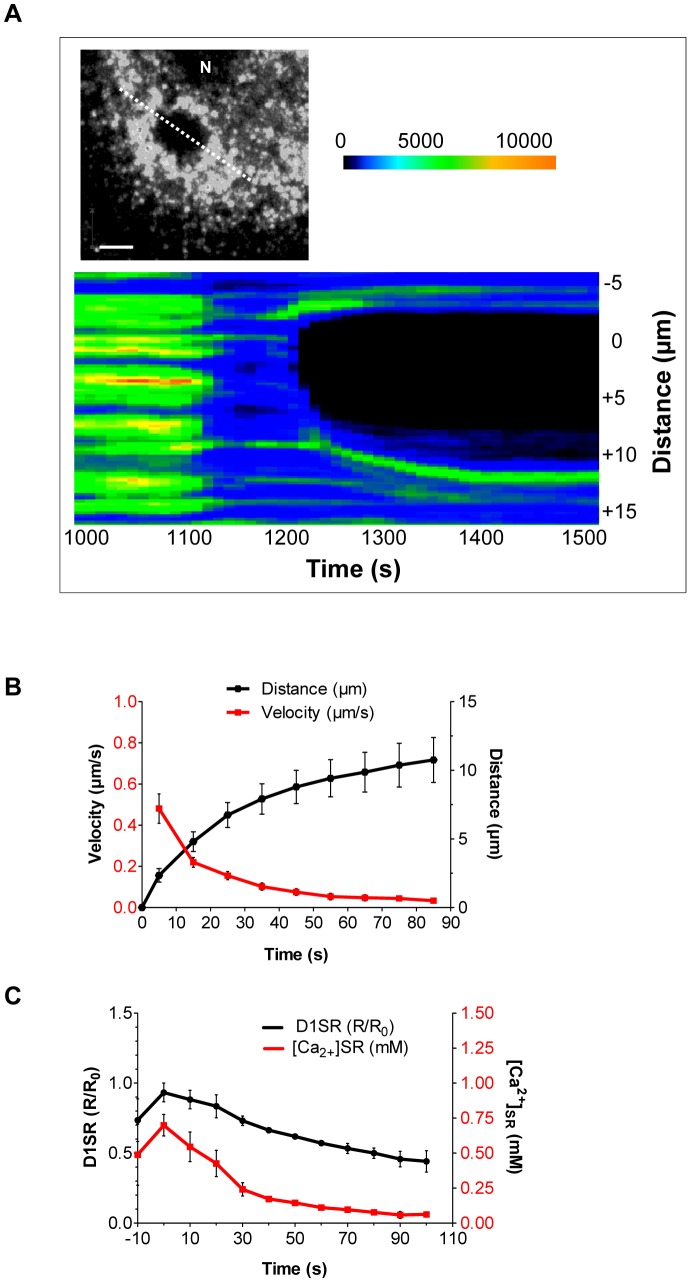
Dynamics of the Ca2+ depletion waves.
A) Heat map generated from the time-lapse fluorescence microscopy movie (10 s intervals) of rat SMCs treated with ET-1 (100 nM) in nominally free extracellular Ca2+, showing that the SR depletion wave expands in a near circular fashion in both directions of the scan line (dotted white line). B) Average travel distance and velocity of ET-1-induced depletion wave vs. time. As the distance from the point of origin increases, the wave velocity decreases asymptotically to zero. C) Average values for R/R0 and [Ca2+]SR at the rim of the depletion wave also decreases as the wave expands over time (ROI = 5, n = 5 independent experiments, mean ± SEM, P<0.005).